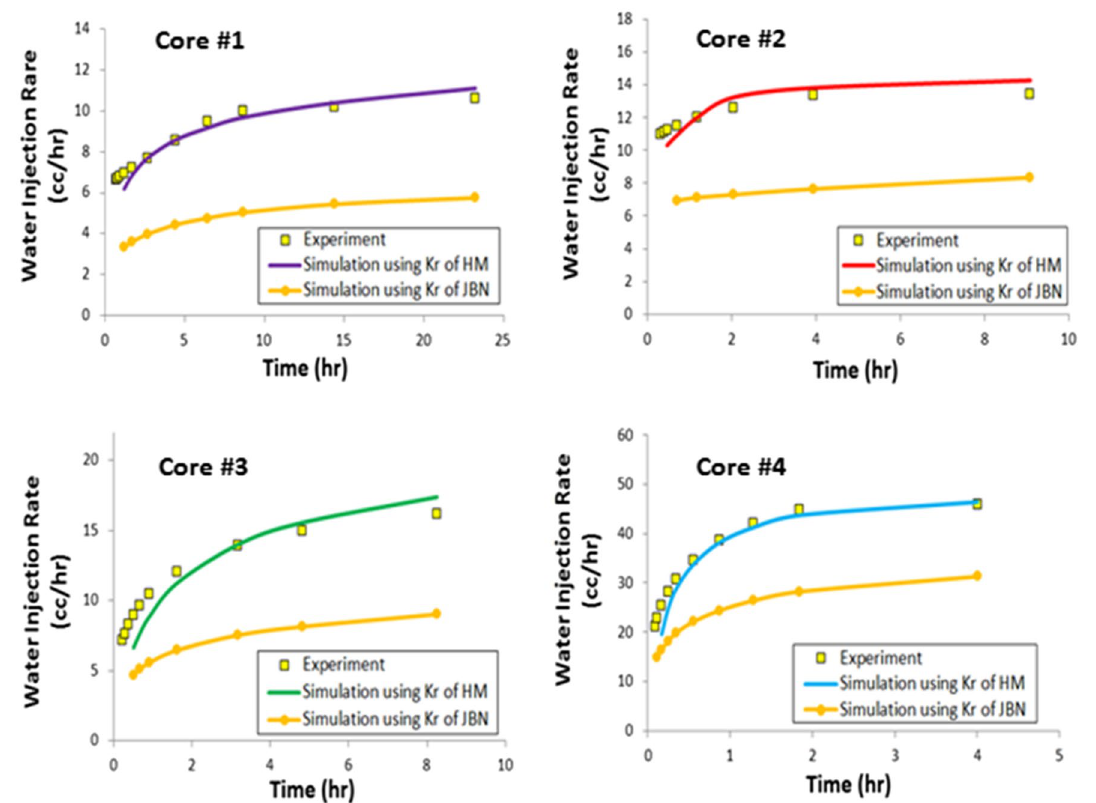
Fig. 5 Experimental results of water injection rate compared to the simulation results using k